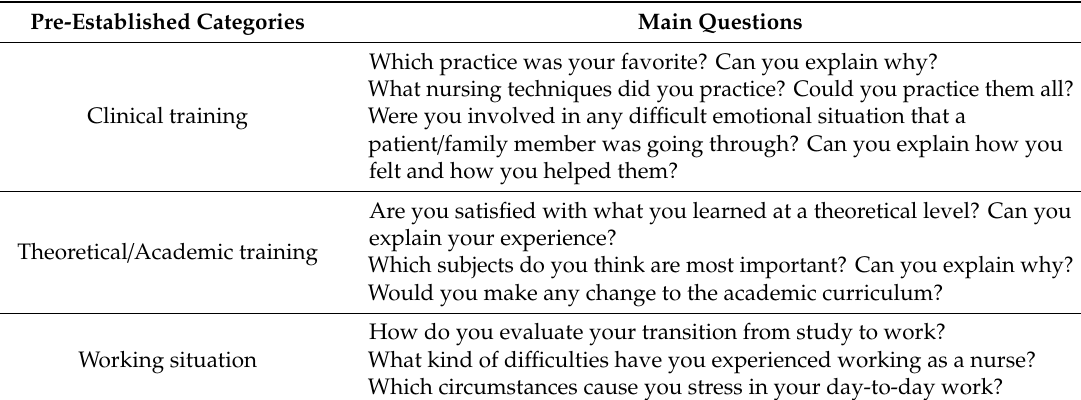
Table 2. Main questions in the interview